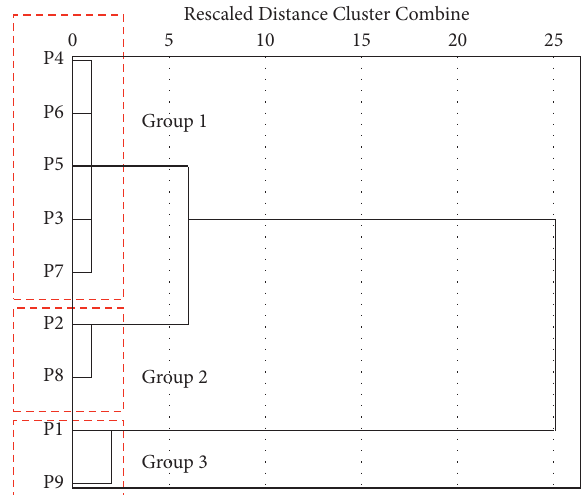
Figure 10: Clustering results.